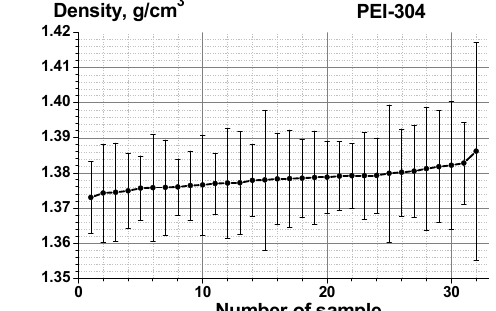
Figure 4. Visualization of free volume in PEI-304, the density is 1.376 g/cm 3 . Successive slices in the range 0–10.5 Å.